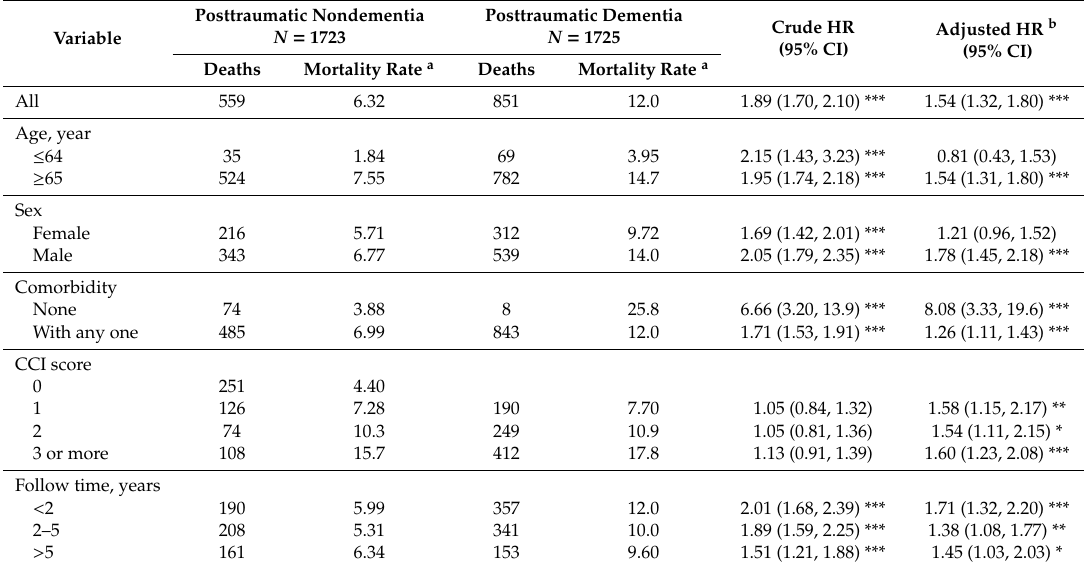
Crude HR Adjusted HR b (95% CI) (95% CI)